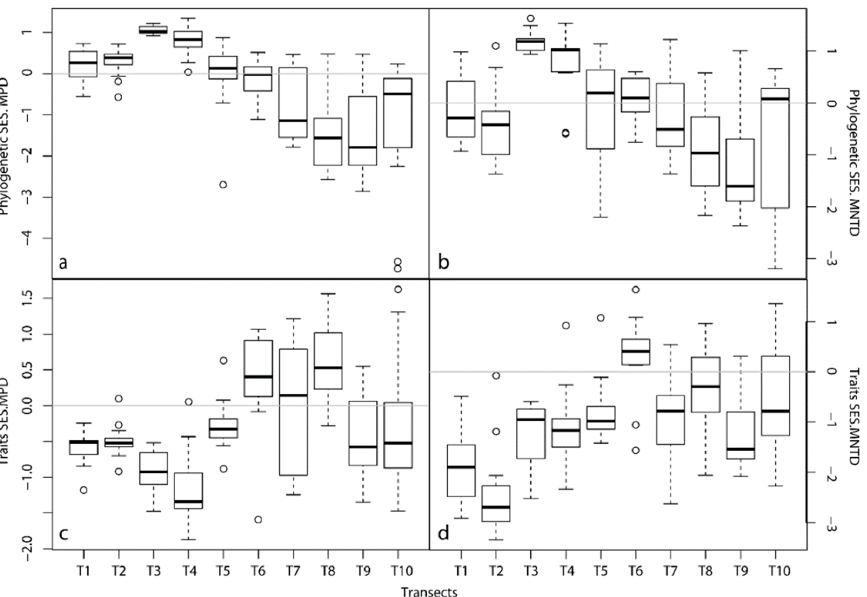
Figure 1. Phylogenetic and functional trait structure along an elevational gradient: ( a ) phylogenetic SES.MPD, ( b ) phylogenetic SES.MNTD, ( c ) trait SES.MPD, and ( d ) trait SES.MNTD.